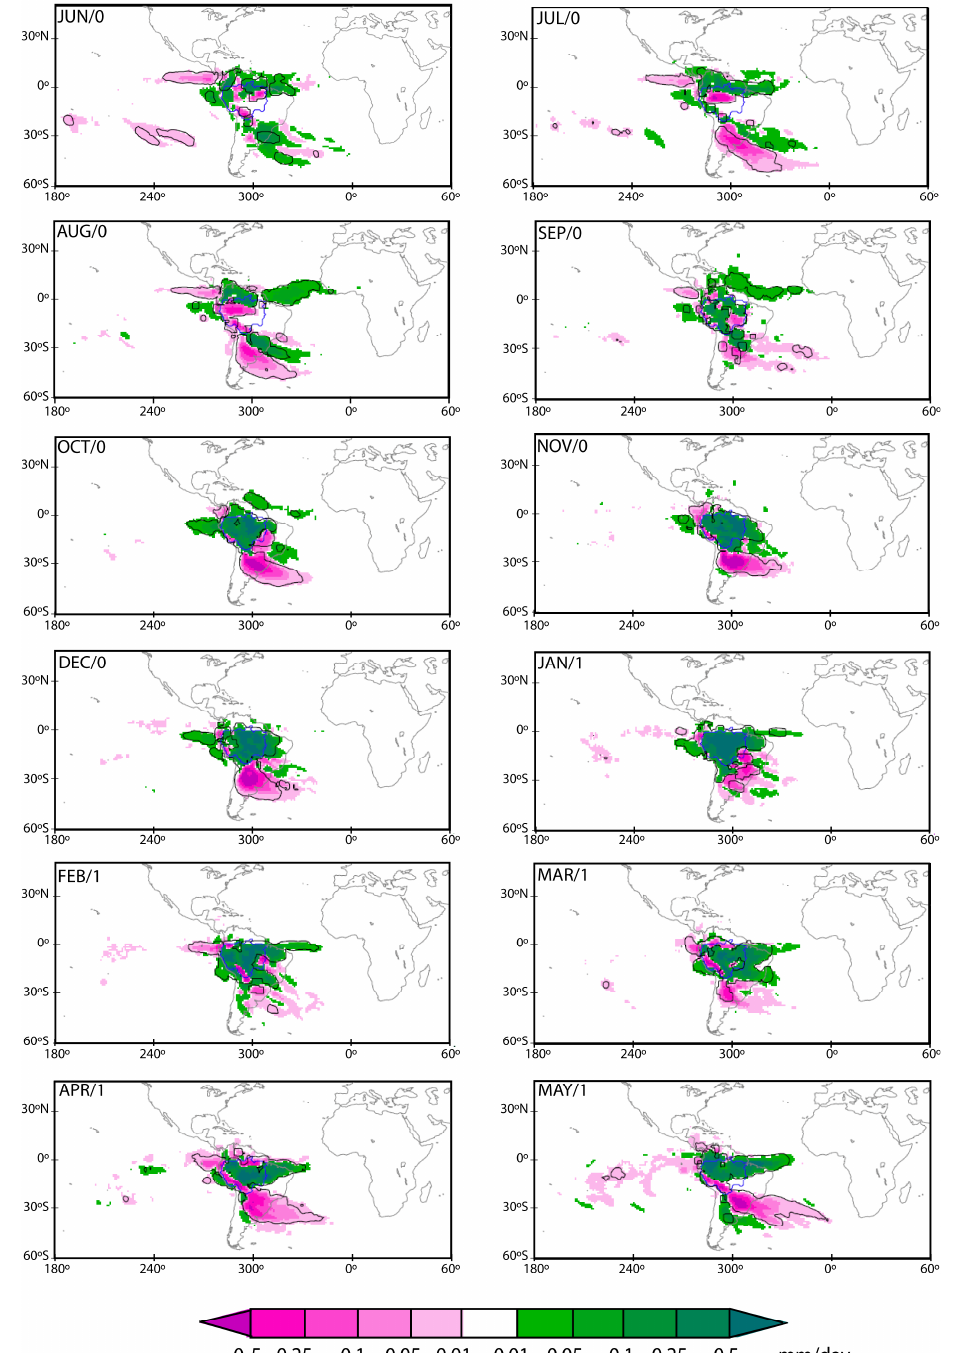
Figure 6 1 Figure 6. Differences of composites of moisture sinks of the Amazon Basin (considering only negative E − P values in the composites using forward analysis) of extreme ENSO episodes. Black contour lines indicate regions where the differences are significant at the 90% level according to the bootstrap test. Pink (green) colours indicate regions where the sinks are more intense during El Niño (La Niña) years. Blue contour line indicates the basin